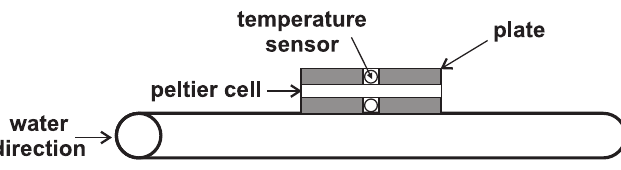
Figure 5. Layout of the second experimental measurement.